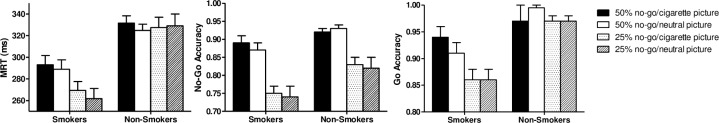
Left: Mean reaction time (+ SEM) of smokers and non-smokers on go trials of the 200-ms stimulus presentation time blocks. Values are presented separately for each no-go stimulus percentage and stimulus type condition. Overall, smokers responded faster than non-smokers (p < 0.001), and the 25% no-go trial condition elicited faster responding than the 50% condition (p = 0.01), especially for smokers (p < 0.001). Middle: Mean (+ SD) proportion of trials of the 200-ms stimulus presentation time blocks on which smokers and non-smokers correctly omitted responding to the no-go stimulus. Overall, non-smokers were more accurate than smokers (p = 0.001) and response accuracy was larger in the 50% no-go trial condition than the 25% condition (p < 0.001). Right: Mean (+ SD) proportion of trials of the 200-ms stimulus presentation time blocks on which smokers and non-smokers responded to the go stimulus. Overall, non-smokers were more accurate than smokers (p = 0.001) and response accuracy was larger in the 50% no-go trial condition than the 25% condition (p < 0.001), especially for the smokers (p < 0.001).